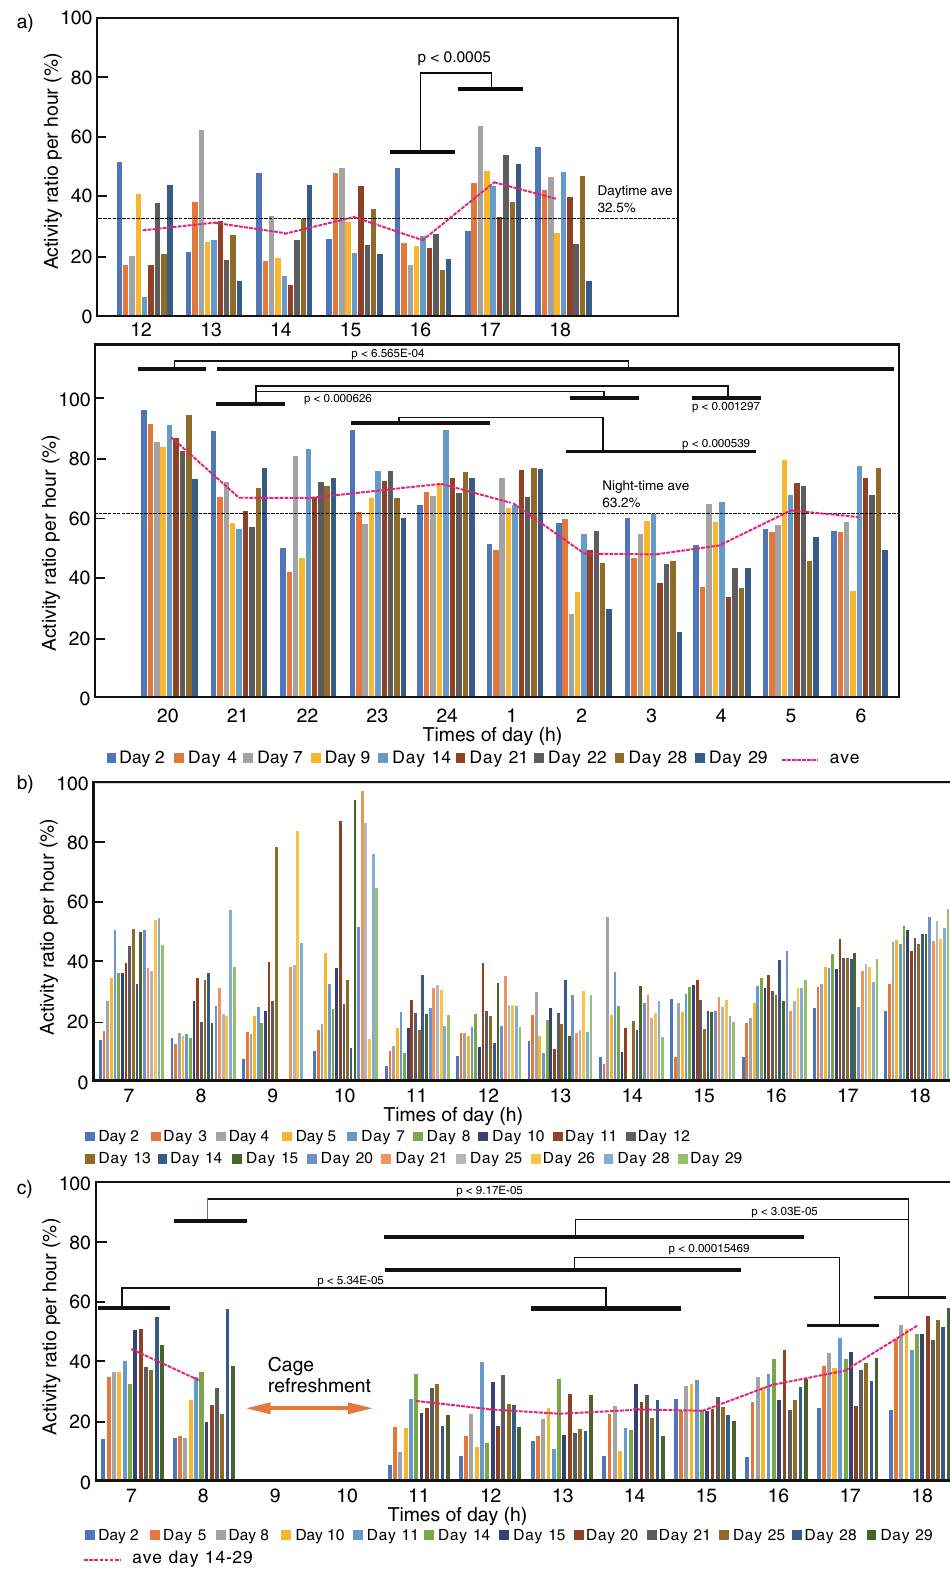
Figure 2. Time-based on the activity ratio per 1-h average. Activity ratio per 1-h average in GC ( a ), HG ( b ), and HG with 1 h removed after refreshment ( c ). The horizontal axis is elapsed time (h), and the vertical axis is activity ratio (%). The dashed line represents the average activity ratio. The horizontal bar in the figure shows the range of p-values. Average 32.5% and 63.2% in the figure are the average activity ratio during daytime and night- time. The recording time varies, so ( a ) is displayed from 12:00 to